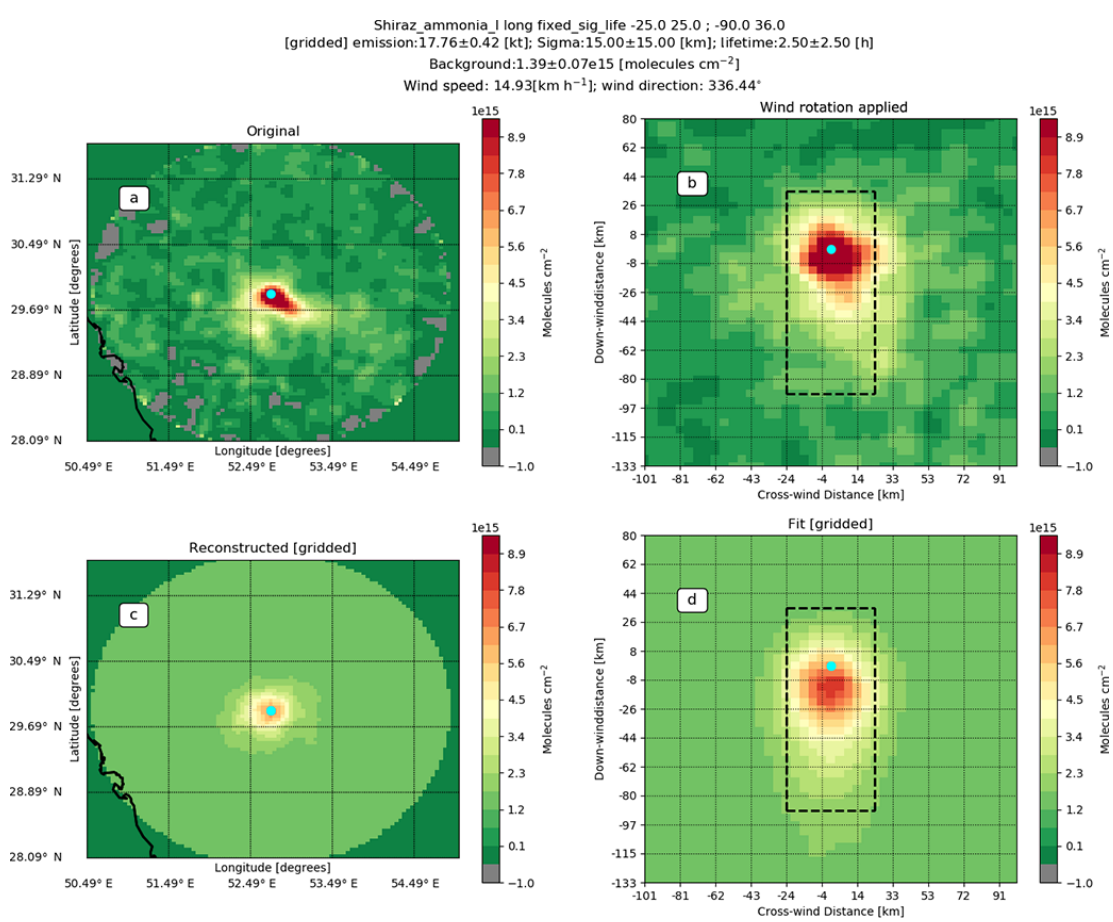
Figure D1. Fit example for the fertilizer plants in Shiraz, Iran. Panel (a) shows the original IASI-A NH 3 total columns (2013–2017) gridded at a 0.05 ◦ × 0.04 ◦ (long, lat) resolution with the pixel-averaging technique with a 15km radius to represent the footprint. Panel (b) shows the same observations after applying the wind rotation algorithm and gridding the observations to a 3km × 4.5km grid. Panel (d) shows the fit to the observations and (c) the reconstruction of the initial plot using the parameters found in the